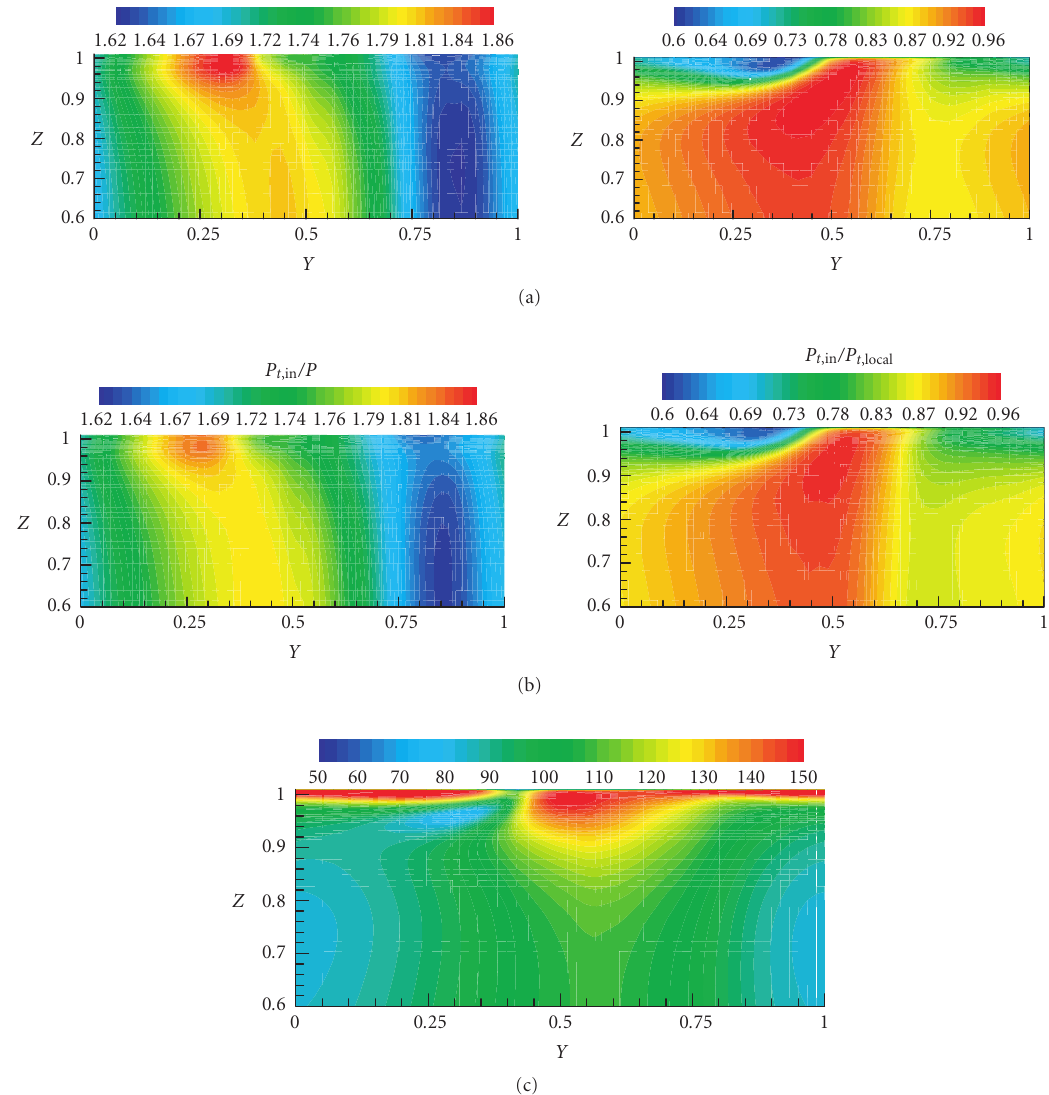
Figure 10: Contours of the pressure ratio ( P t ,in /P ) and ( P t ,in /P t ,local ) at a streamwise location of 120% from the leading edge of the blade, (a) baseline flat tip, (b) desensitized flat tip, and (c) contours of streamwise velocity (m/s) for baseline flat tip.